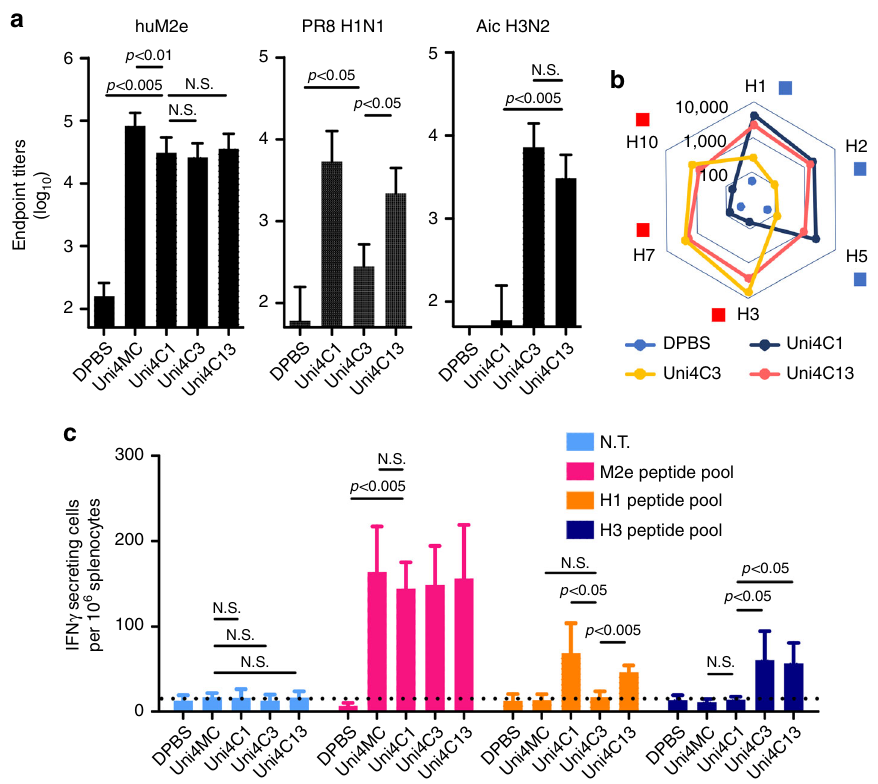
Fig. 2 Humoral and cellular immune responses of vaccinated mice. a Serum IgG endpoint titers against huM2e, formalin-inactivated PR8 H1N1 or formalin- inactivated Aic H3N2. ( n = 10) b Radar diagram depicting breadth of immune serum binding to HA subtypes. Because frequent human infection with fatal zoonotic in fl uenza H5N1, H7N9, and H10N8 viruses in recent years represents possible emerging pandemics, the binding activities of immune sera to H5, H7, and H10 were tested. The waning human herd immunity against H2N2 in fl uenza strain and low mutation rate make it likely that a new pandemic could arise from the current circulating H2N2 strain among birds and swine. H2 was included in the serum binding assay. The squares besides HA subtypes indicate HA phylogenetic groups by coloring: blue for group 1 and orange for group 2. c Speci fi c cellular immune responses against M2e, H1, and H3. Peptide pool re-stimulated interferon gamma (IFN γ )-secreting cell clones were determined using ELISpot assay. ( n = 4) Data are presented as mean ± SD Statistical signi fi cance was analyzed by t -test for a and c . P values shown in bar charts and N.S. indicates no signi fi cance between two compared groups. The experiments were repeated twice with similar